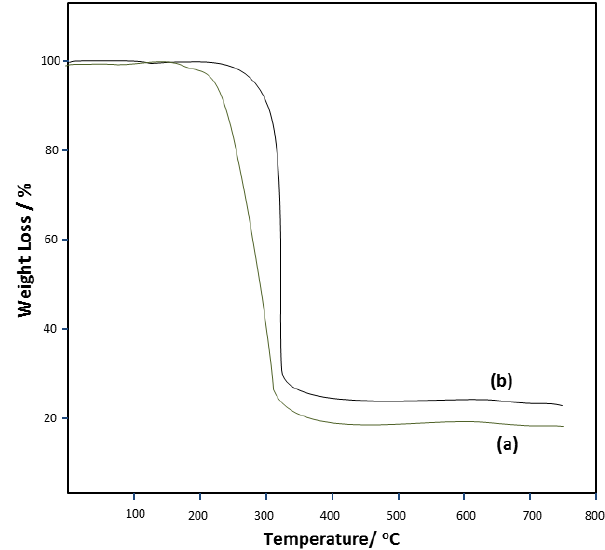
Figure 14. Thermogravimetric curves of (a) [Sn{S 2 CN(CH 2 ) 4 } 2 {C 6 H 5 } 2 ] and (b) [Sn{S 2 CN(CH 2 ) 4 }{C 6 H 5 } 3 ] in N 2 [16]. Redrawn from [16], with permission from Elsevier (Copyright 2018).